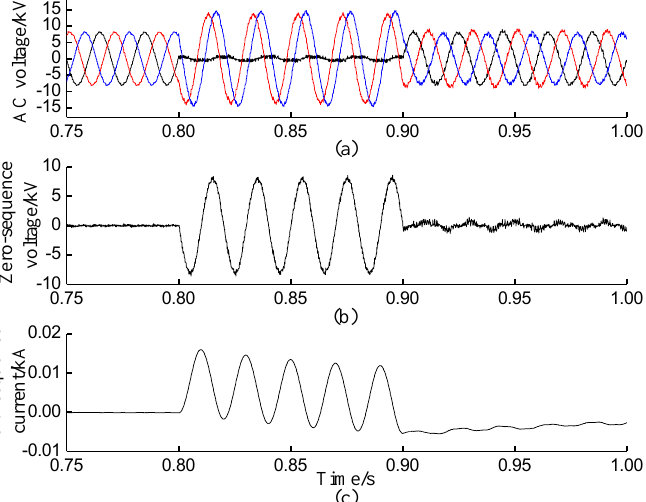
Figure 12. Fault response characteristics of MMC2 after optimization. ( a ) Three-phase AC voltage (black is A-phase, red is B-phase, blue is C-phase). ( b ) AC zero-sequence voltage. ( c ) AC zero-sequence current.